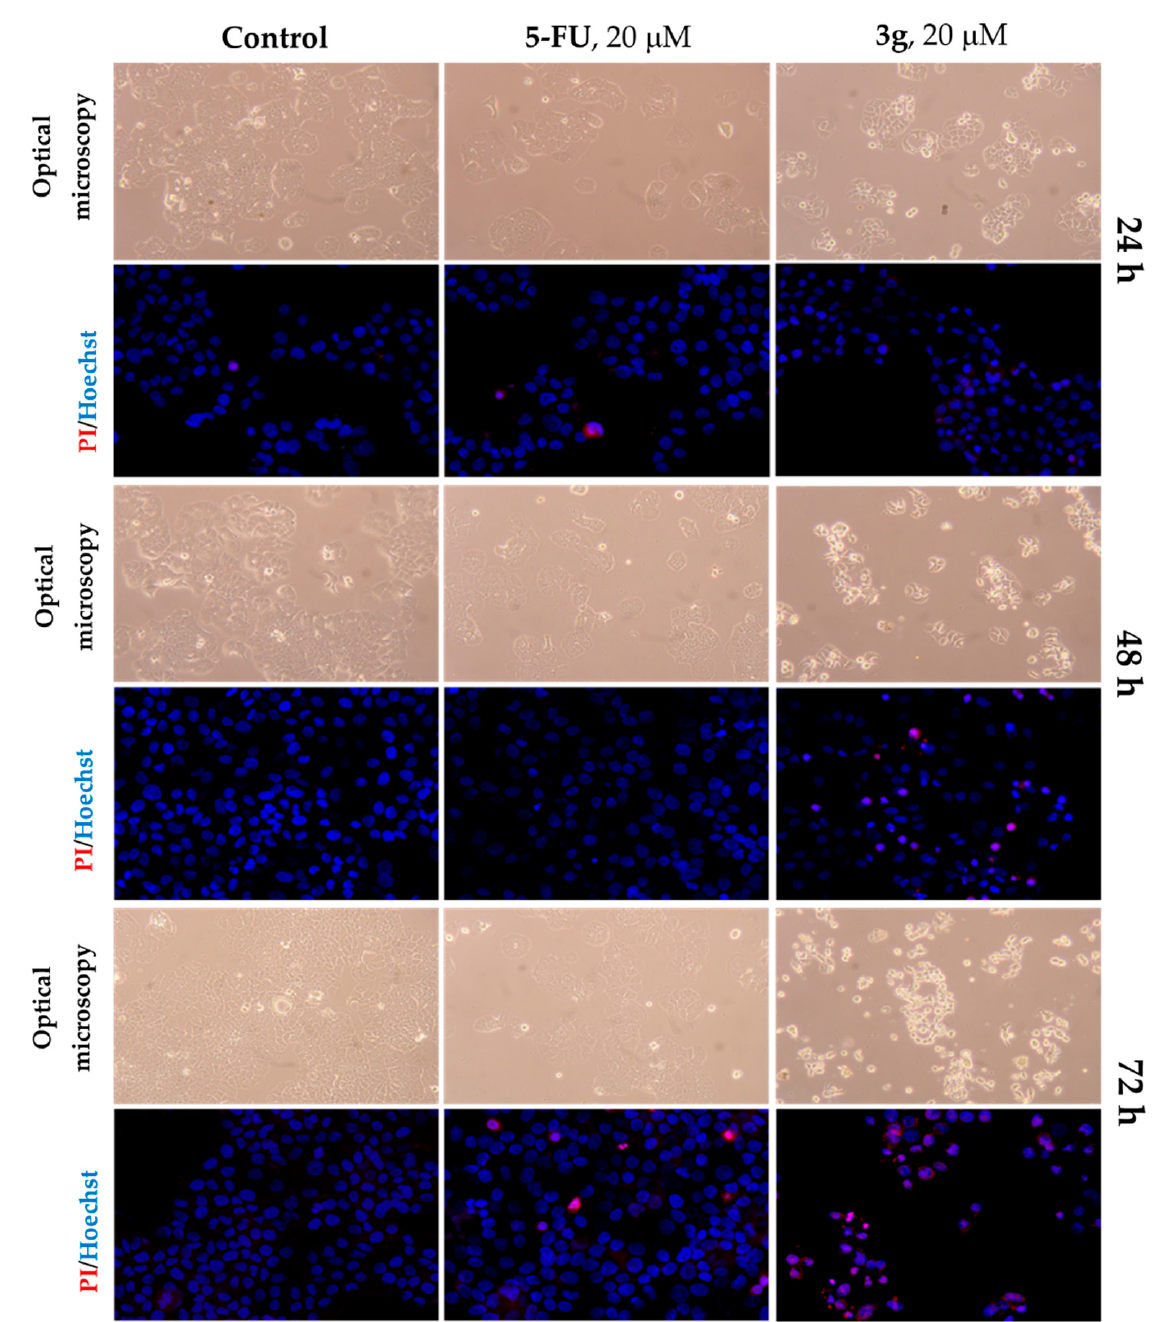
Figure 1. PI/Hoechst 3342 staining results. T47-D cells were incubated for 24, 48 and 72 h with 5-fluorouracil (5-FU) and 3g at 20 µM. Untreated cells were considered the control of the experi- ment. Cells were visualized in an Optical microscope Olympus CKX41 coupled to a digital camera (Olympus SP-500UZ) and in an Axio Imager A1 microscope (fluorescence). The resulting images were treated in ImageJ software.